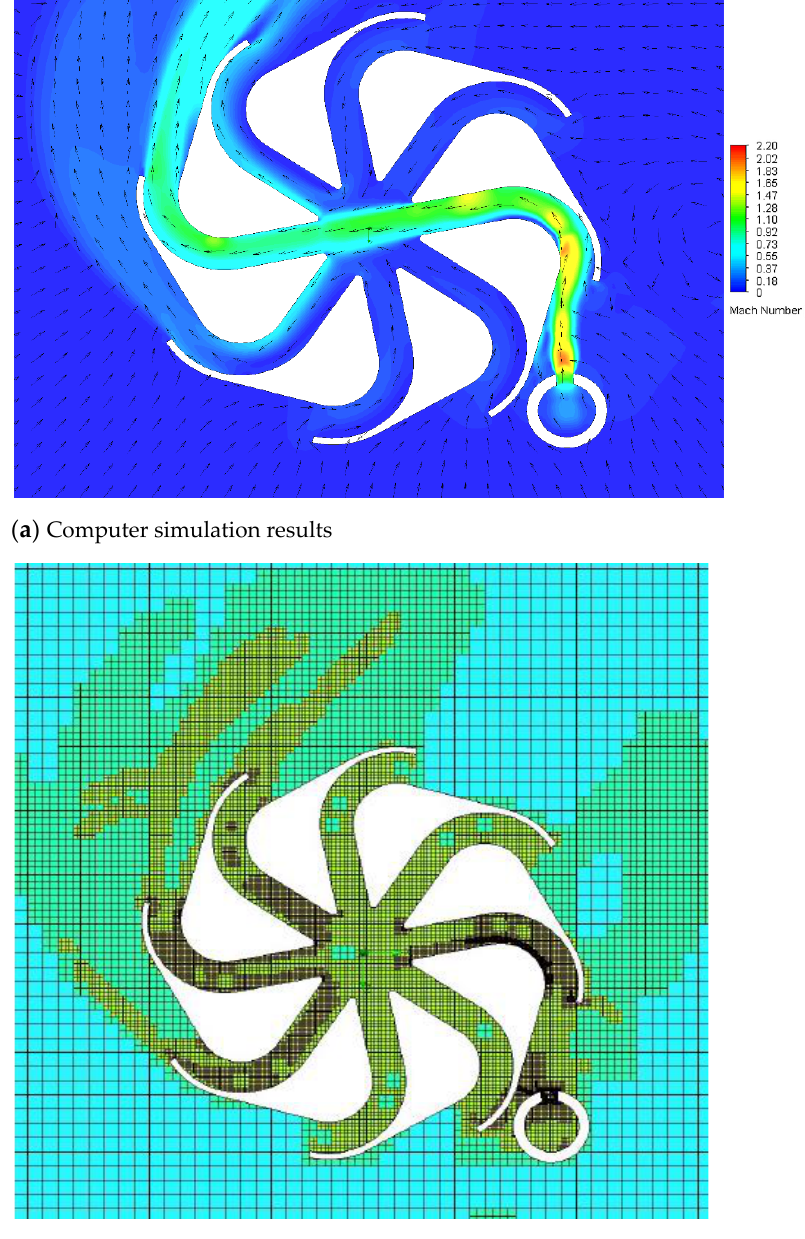
Figure 10. Computer simulation results for the turbine with an external working gas inlet (Operation mode 3). Source: authors’ development.